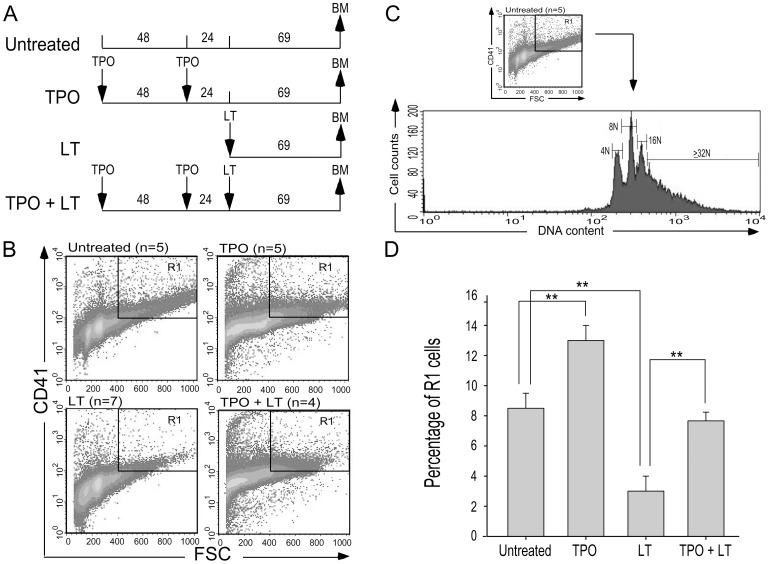
TPO pretreatments ameliorated LT-mediated megakaryopoiesis suppression in mice.(A) The experiment outline used in bone marrow (BM) experiments. Flow cytometry analysis using mouse bone marrow cells was performed at 69 hours after LT treatments. Following a previously described method [69], the population of polyploid megakaryocytes was gated as CD41 high (fluorescent intensity>102) and large (FSC>400) cells in all groups (B, R1 regions). The DNA content of R1 cells in the untreated group was illustrated (C), and relative R1 cell population (percentage of total 2×105 cells) was quantified (D). **p<0.01 compared between indicated groups.